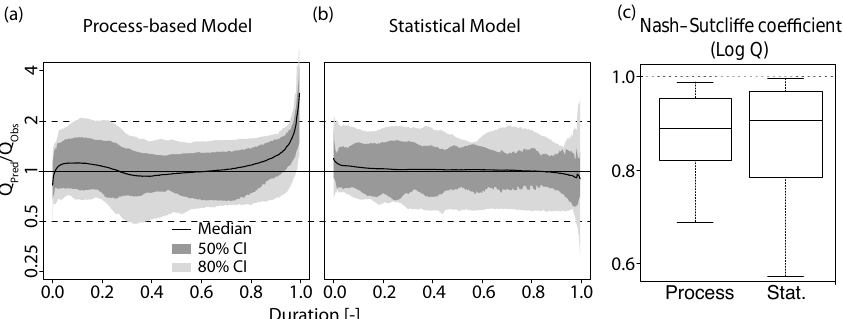
Figure 4. Flow duration curve prediction performance in ungauged basins. The error duration curves of the leave-one-out cross-validation analysis using the process-based and statistical models are presented in panels (a) and (b) , respectively. Relative errors are plotted on a log scale in order to allow the graphs to be balanced on the y axis: a relative prediction error of 2 (the model predicts double the observed value) is at the same distance from y = 1 (perfect prediction) as a relative error of 1 / 2 (the model predicts half the observed value). Durations are plotted on the x axis, with x = 0 and x = 1 for the highest and lowest flow quantiles, respectively. Panel (c) shows box plots of Nash–Sutcliffe coefficients computed from log-transformed flow quantiles.